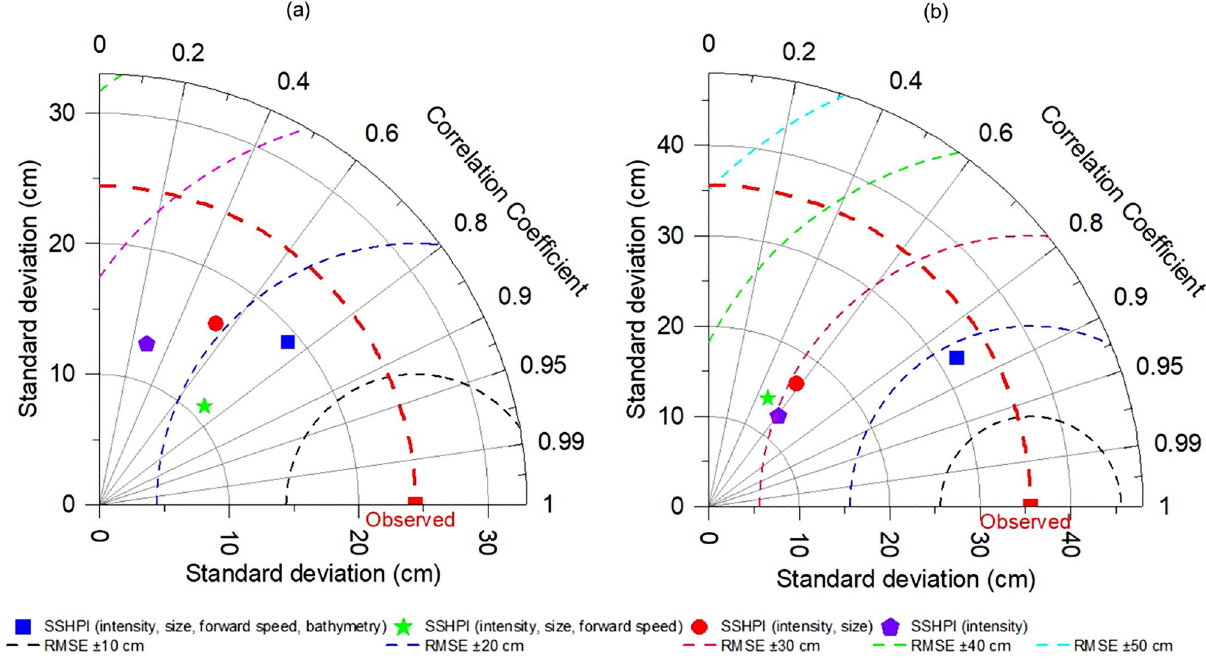
Figure 6. Taylor diagram describing the performance of SSHPI with varying coastal geometry (a) open coast (n = 70); (b) semi-enclosed bays (n = 47). The azimuthal angle represents correlation, the radial distance the standard deviation, and the semicircles centered at the “Observed” marker the root mean square error. The red dashed line constitutes the standard deviation of observed peak storm surge heights.